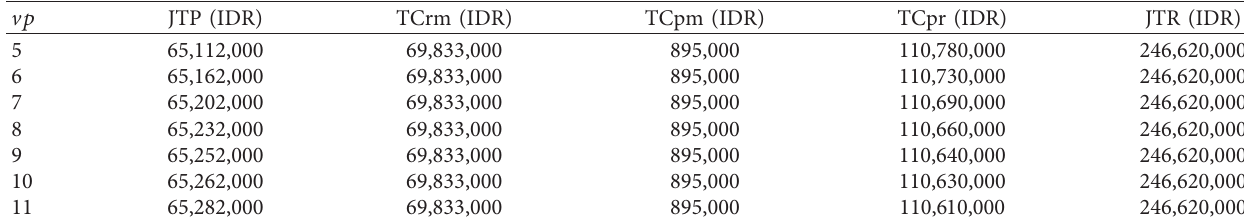
Table 12: Sensitivity analysis of the effect of vp on cost, revenue, and profit.